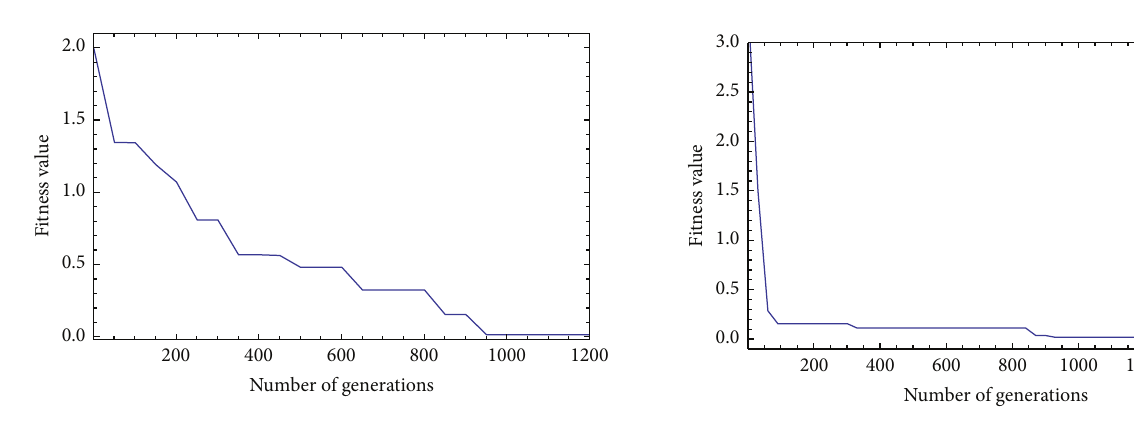
Figure 12: Performance graph for Case 2.